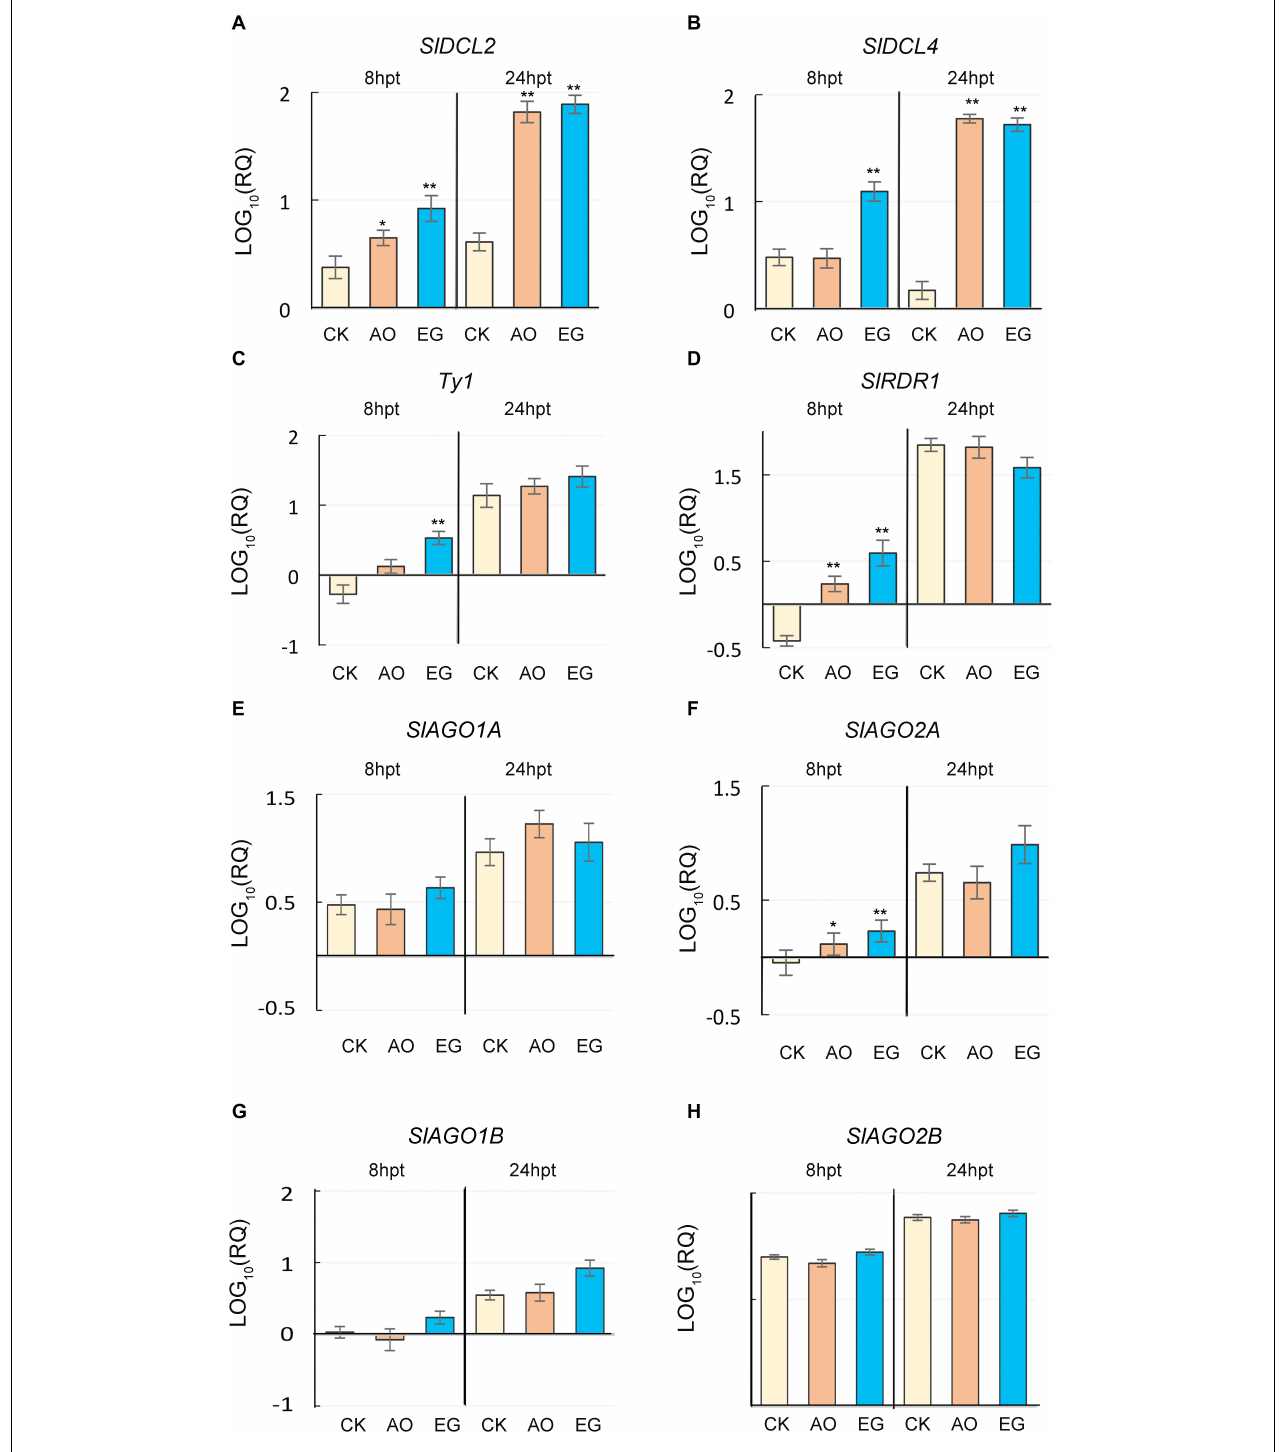
FIGURE 5 | Effects of anise oil and eugenol on the expression of RNA silencing genes in tomato plants. Fourteen-day-old tomato seedlings were treated with a control solution (CK), anise oil (AO), or eugenol (EG). Total RNA was extracted from these plants at 8 h post-treatment (hpt) and 24 hpt. The expression levels of RNA silencing genes, SlDCL2 (A) , SlDCL4 (B) , Ty-1 (C) , SlRDR1 (D) , SlAGO1A (E) , SlAGO2A (F) , SlAGO1B (G) , and SlAGO2B (H) were analyzed by RT-qPCR. The β -actin expression level was used as the internal control. Relative gene expression levels were normalized against the expression level in untreated tomato plants. Data were analyzed with the 2 − (cid:49)(cid:49) Ct method. Bars represent the mean ( ± standard error of the mean) of three independent biological replicates each with three technical replicates. Significant differences between control and anise oil- or eugenol-treated plants were assessed with Student’s t -test ( ∗ P < 0.05; ∗∗ P < 0.01).